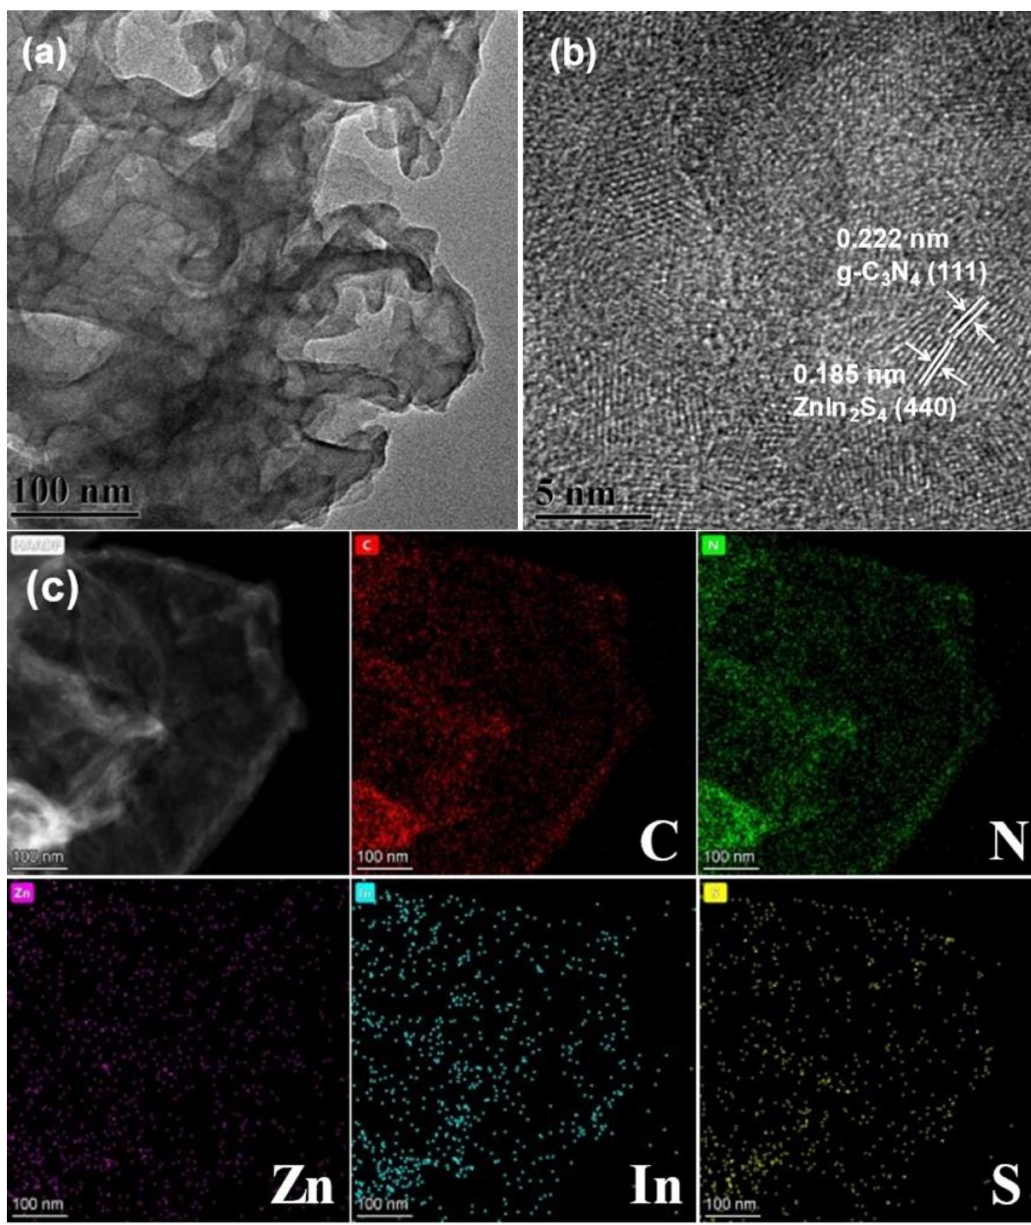
Figure 4. ( a ) TEM ( b ) HRTEM and ( c ) EDS element mapping of 20%